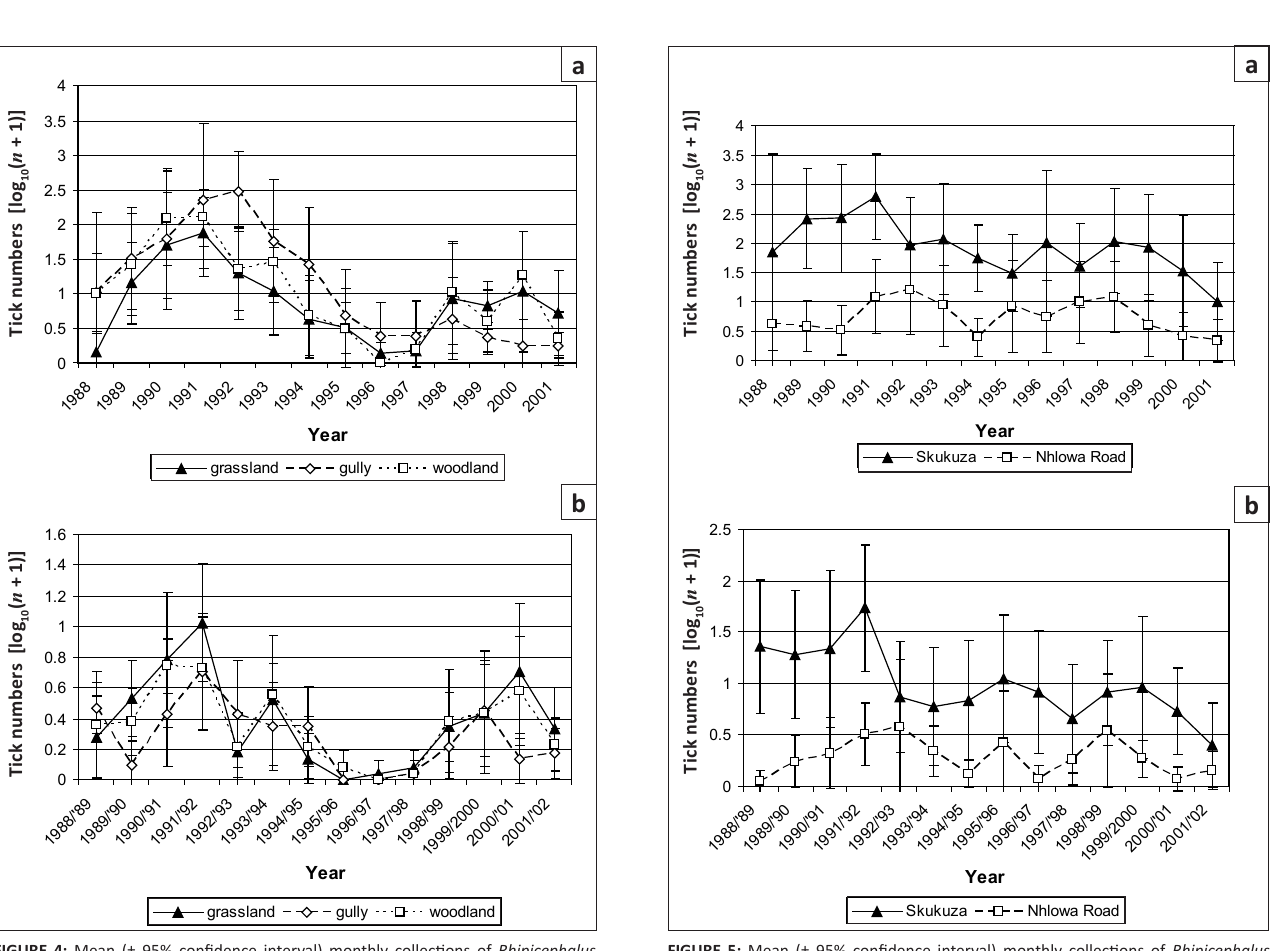
FIGURE 4: Mean (± 95% confidence interval) monthly collections of Rhipicephalus appendiculatus a) larvae and b) nymphs during the active periods by habitat and year at Nhlowa Road.